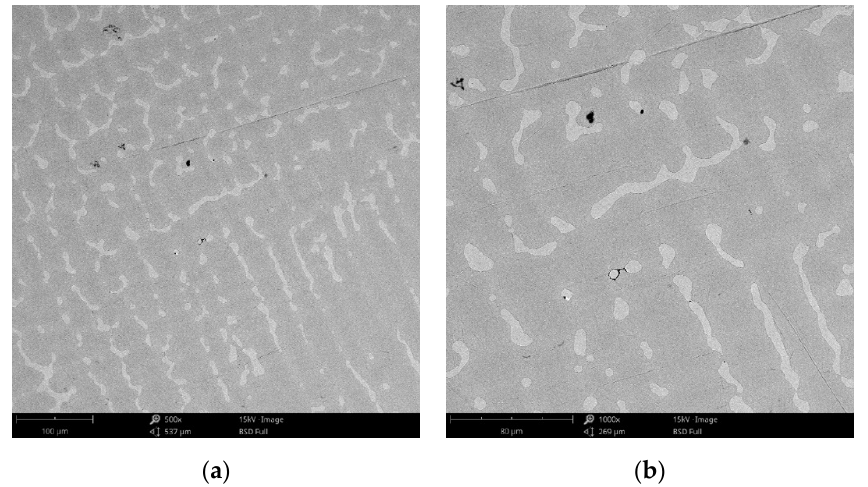
Figure 13. SEM images of the CCc-5 sample after corrosion tests at ( a ) 500×; ( b ) 1000×.